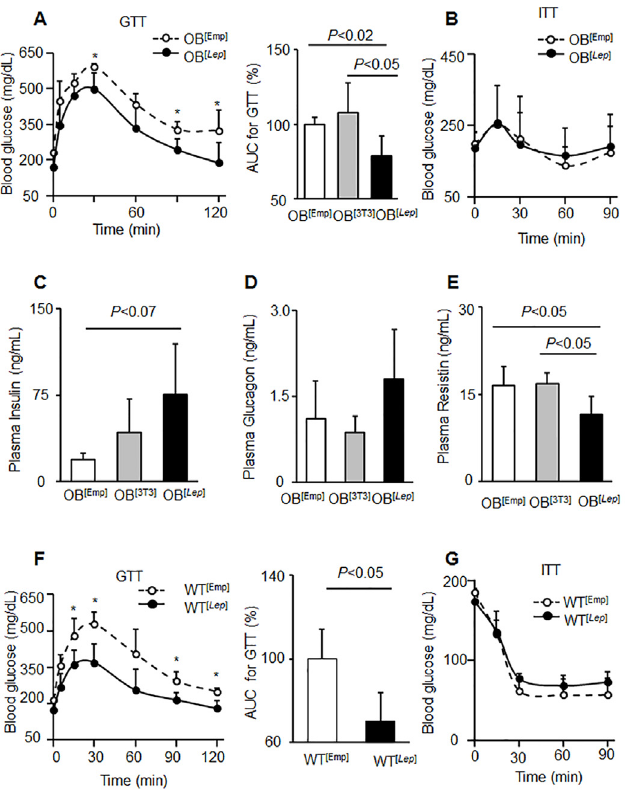
Fig 5. Leptin improves glucose tolerance and reduces resistin. (A,B) Glucose tolerance tests (GTT) (A) or insulin tolerance tests (ITT) (B) were performed in fasting overnight mice OB [Emp] (open circles, n = 5) and OB [ Lep ] (filled circles, n = 5). GTT and ITT tests for OB [3T3] group are shown in S4 Fig. Average blood glucose (mg/dL) concentrations are displayed for each time point. Asterisks indicate significant differences P < 0.05, Student ’ s t-test. The area under the curve (AUC) for each GTT was calculated using a trapezoidal approximation and displayed as percent of the control OB [Emp] group (100%). (C-E) Plasma insulin (C), glucagon (D), and resistin (E) concentrations were measured by ELISA in OB [Emp] (white bar, n = 4), OB [3T3] (gray bar, n = 3), and OB [ Lep ] (black bar, n = 7). Statistical difference was examined by one-way ANOVA followed by Tukey ’ s post hoc test. (F, G) WT mice with diet-induced obesity (Study 2) were injected with encapsulated acellular capsules (WT [Emp] ) and encapsulated 3T3 Lep (WT [ Lep ] ) in both visceral fat pads (total 0.6 * 10 6 adipocytes for each cell type). GTT (F) or ITT (G) were performed in fasting overnight mice WT [Emp] (open circles, n = 3) and WT [ Lep ] (filled circles, n = 5). All data are represented as mean ±